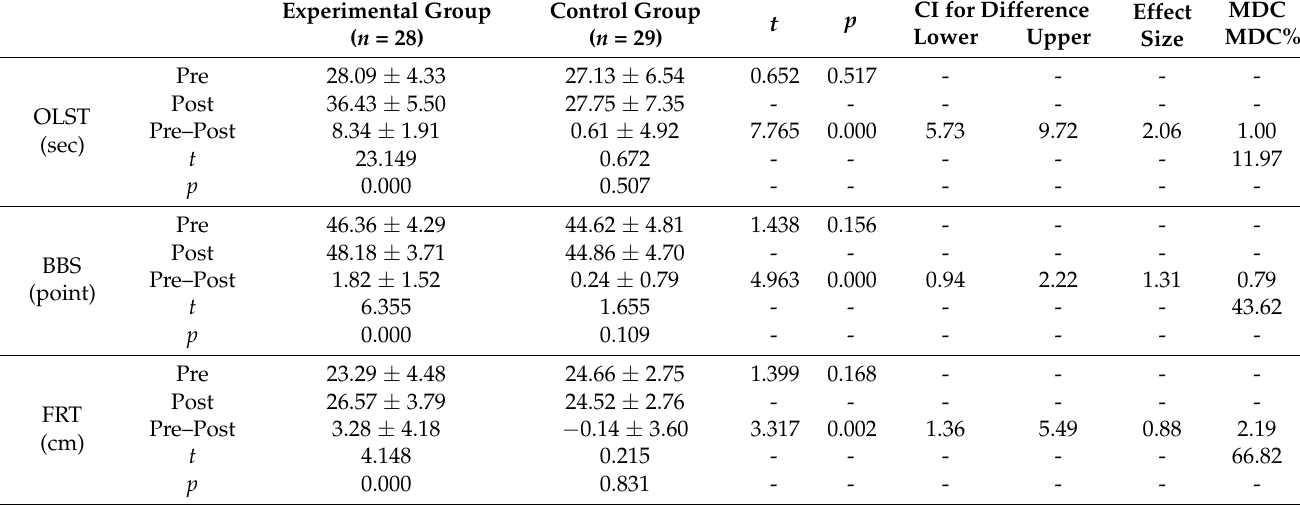
Table 2. Changes in physical